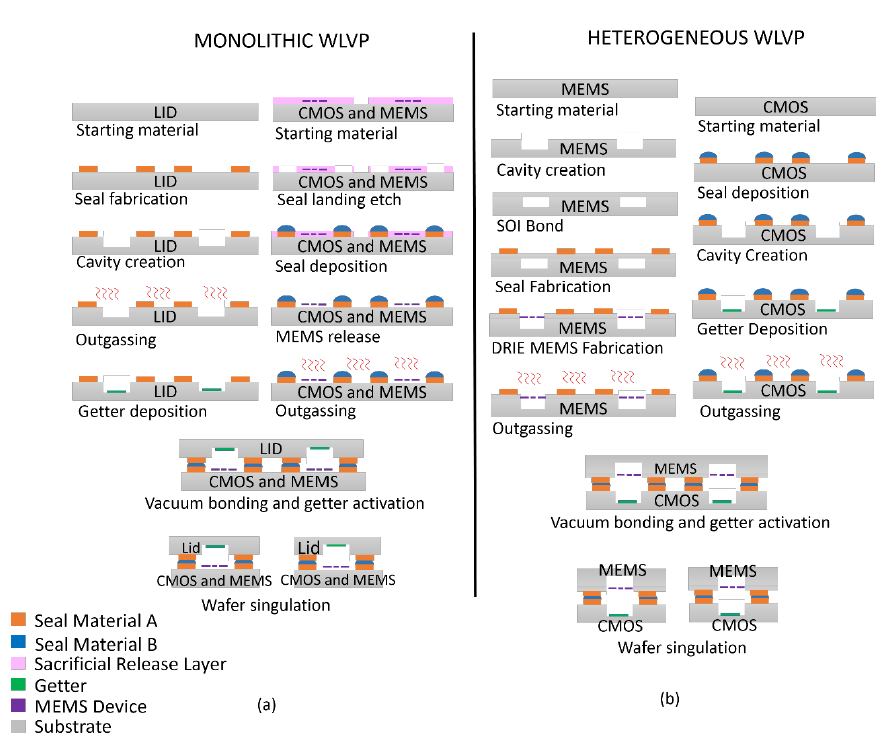
Figure 2. Examples of wafer-level vacuum packaging (WLVP) process flows. ( a ) Monolithic example in which complementary metal-oxide semiconductor (CMOS) and microelectromechanical systems (MEMS) are capped with a passive lid wafer; ( b ) Heterogeneous example in which CMOS and MEMS are on separate wafers, which are bonded to form a WLVP.